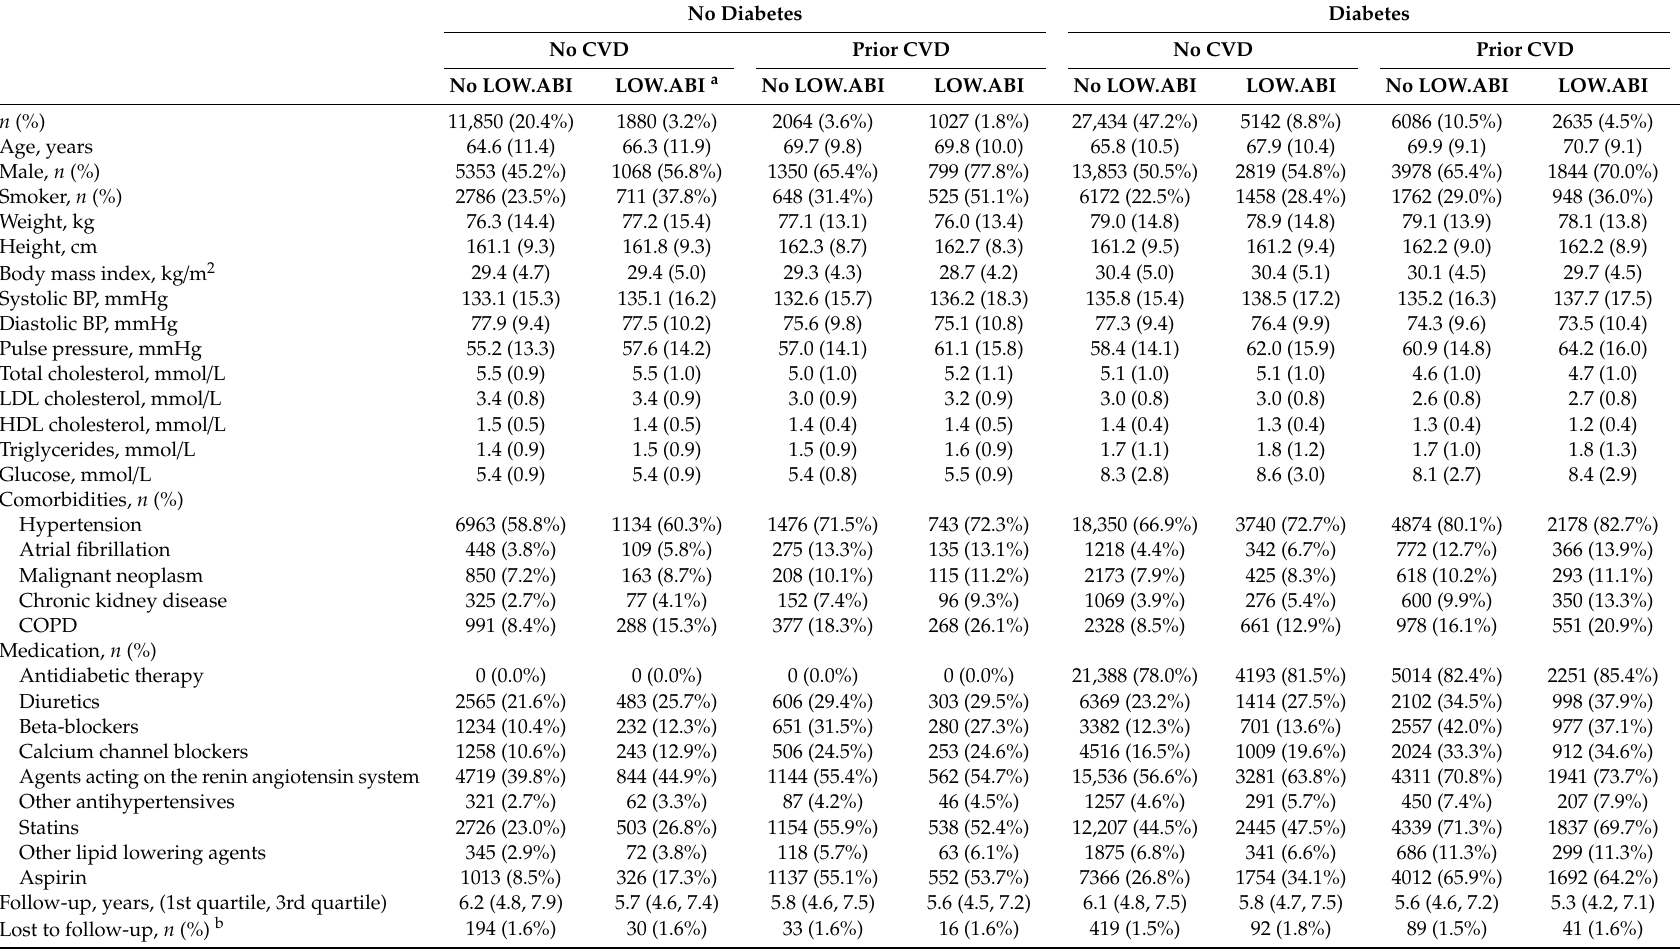
Table 1. Baseline characteristics of the study population according to diabetes, prior CVD, and ankle–brachial